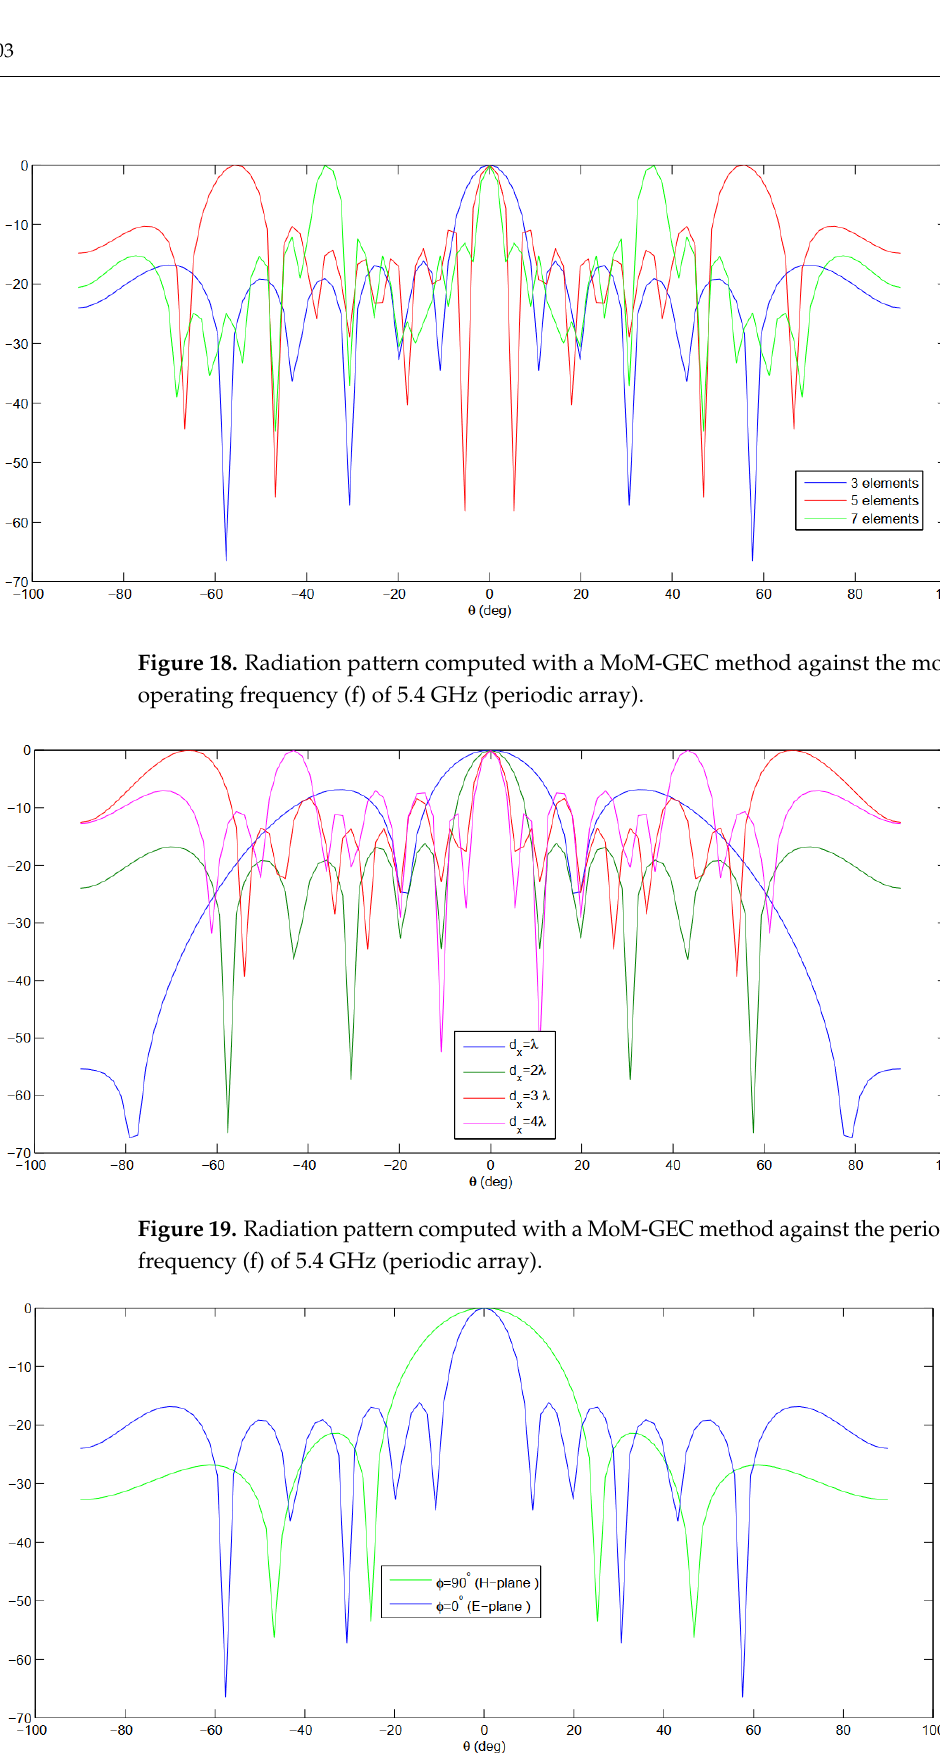
Figure 20. E-and H-plane cuts of the radiation pattern computed with a MoM-GEC method at the operating frequency (f) of 5.4 GHz (periodic